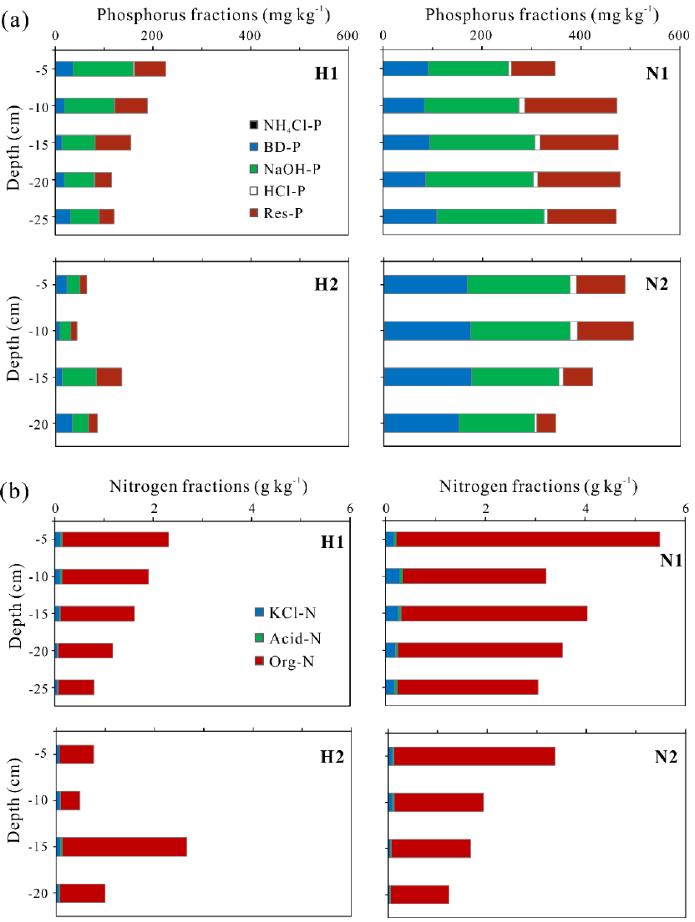
Figure 2. ( a ) Phosphorus and ( b ) nitrogen fractions in sediments by depth at each sampling site (H1, H2, N1, and N2). H2, N1, and